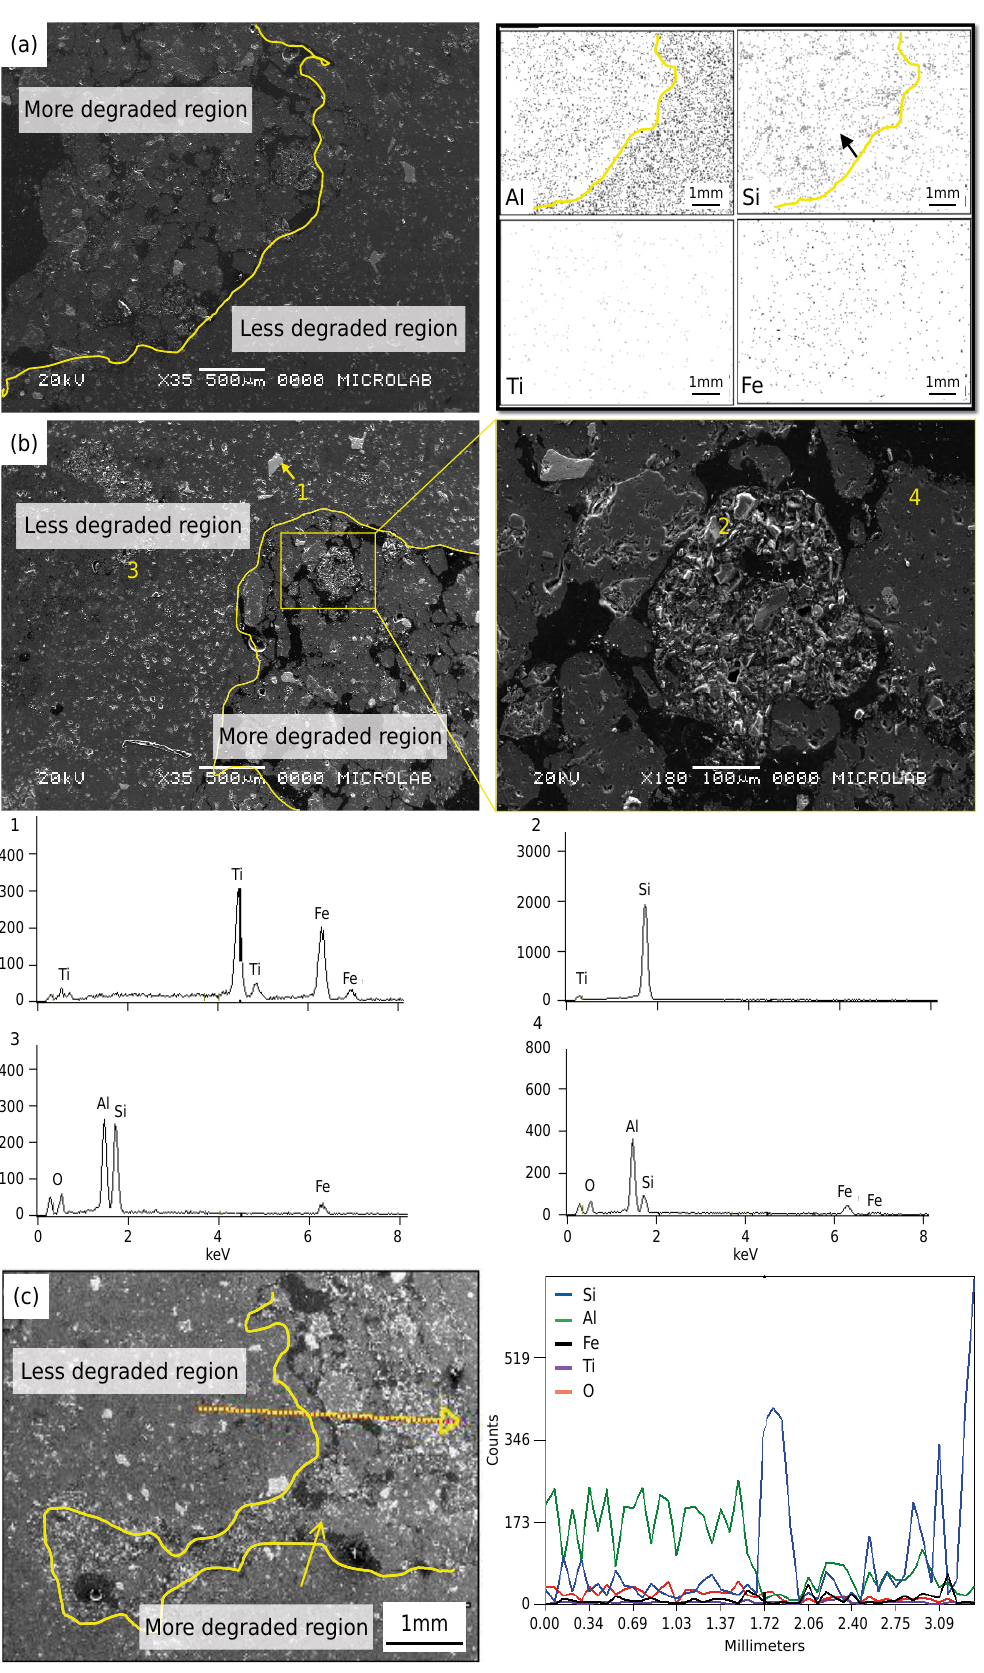
Figure 5. Scanning electron microscopy photomicrograph and microchemical map that shows the Si accumulation in the more degraded portions of bauxite. (a) The arrow indicates the direction of Si accumulation in microchemical mapping. (b) Microchemical analysis by Electron Dispersive X-ray (EDS), which indicates the chemical compositions of different regions of the bauxite. (c) Linear microchemical analysis, which indicates an increase in Si in the more degraded portions of the bauxite. The yellow arrow indicates the direction of enrichment in